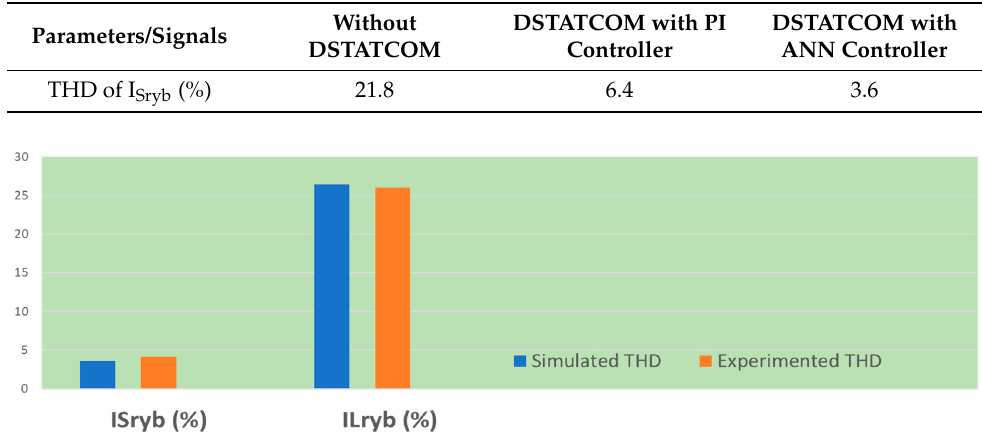
Figure 18. THD comparison of the simulated model and the experimental set-up.